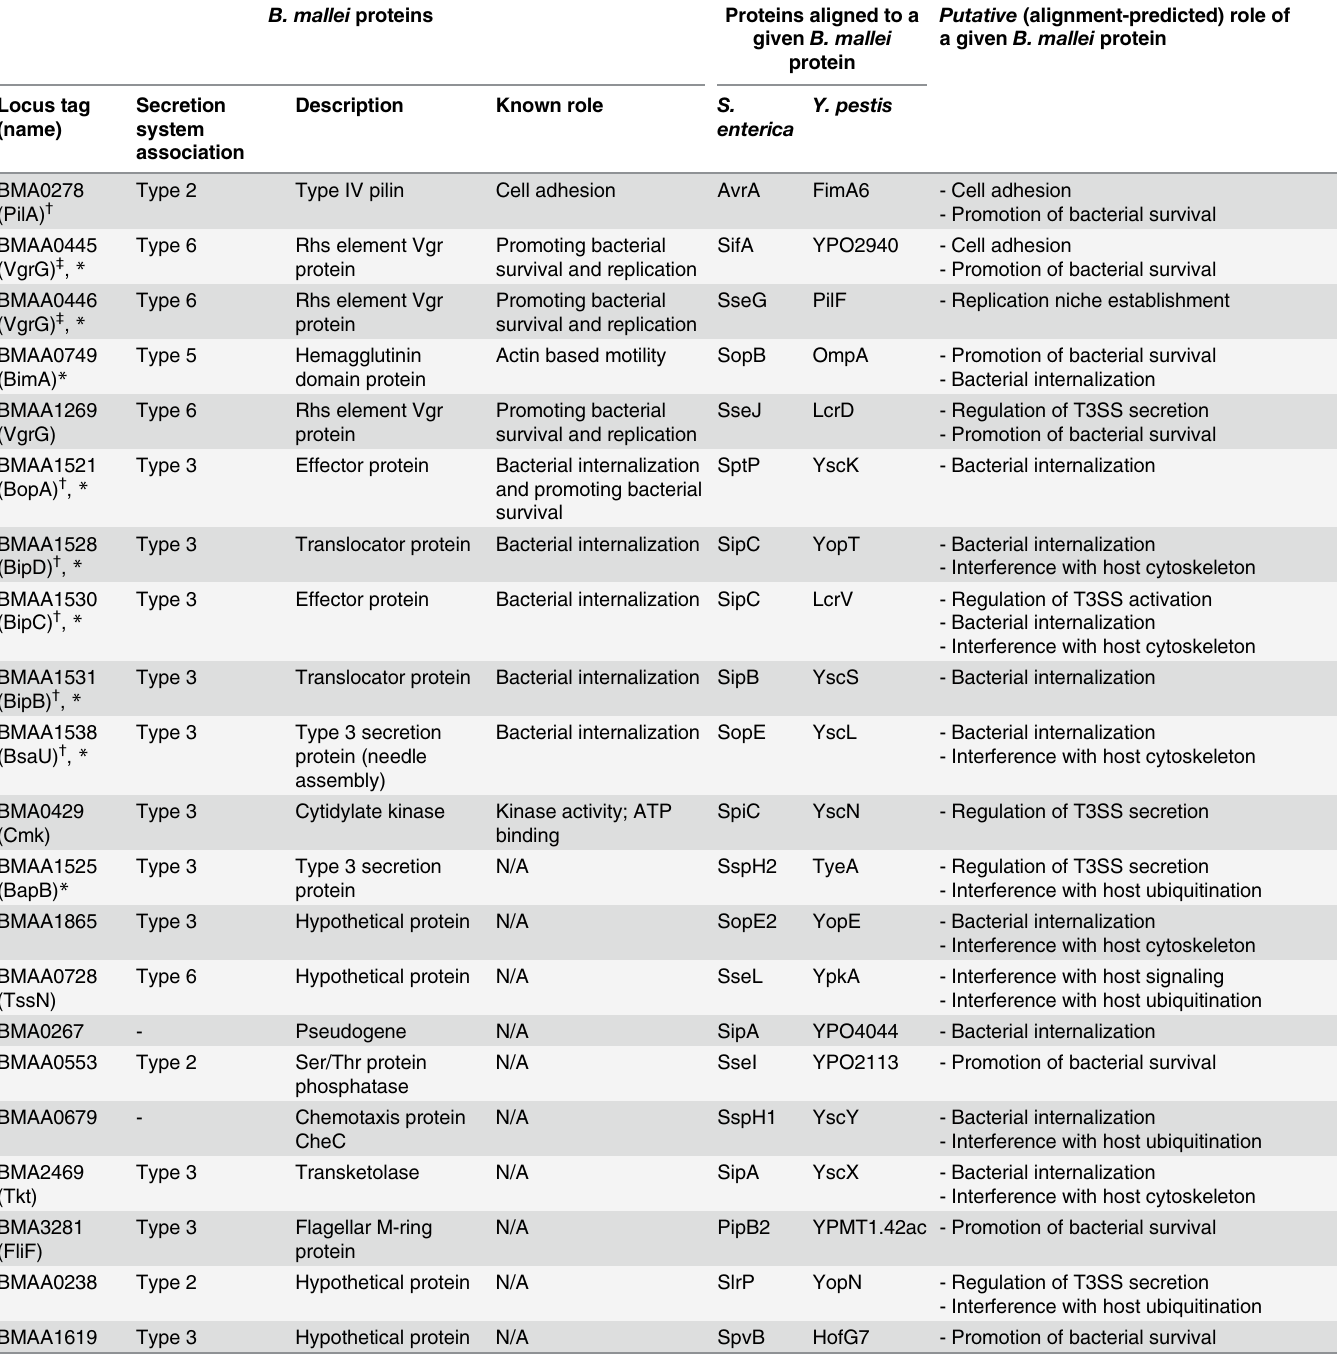
Table 5. Putative role of B. mallei proteins inferred from host-pathogen interaction network alignment